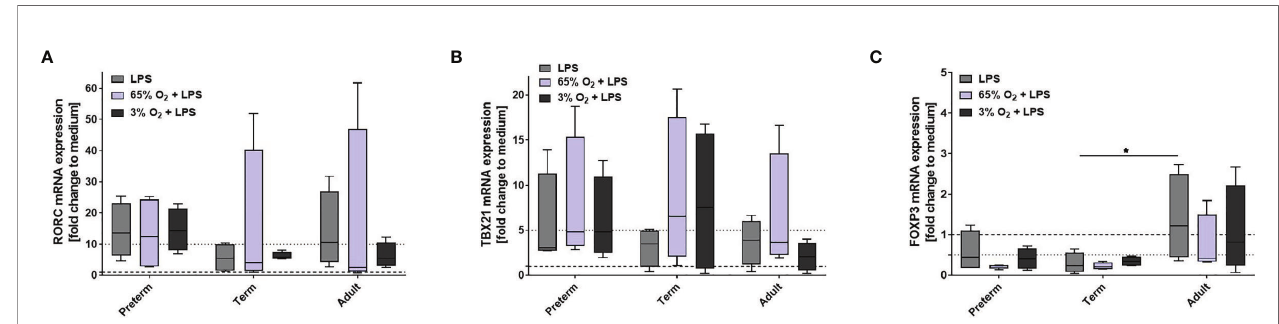
FIGURE 8 | Neonatal CD4+ T cell polarization by supernatants of macrophages (M Ф ) primed with various O 2 concentrations followed by LPS. Neonatal CD4+ T cells were incubated for 6 days with supernatants of preterm, term or adult M Ф after priming M Ф with 65% O 2 or 3% O 2 followed by LPS compared to LPS alone. Supernatants were collected after incubation of M Ф for 72 h (48 h 65% O 2 or 3% O 2 followed by 24 h 21% O 2 with or without LPS). mRNA was assessed using RT qPCR. Box plots of RORC (A) , TBX21 (B) and FOXP3 (C) mRNA expression normalized to b -Actin depicted as a fold change to the medium control. The dotted line at 1 indicates the normalization level and the second dotted line is an auxiliary line for visualization (n=4 independent 72 h supernatants were used (same as Figure 6 ) on neonatal CD4+ cells isolated from one donor, LPS values were re-used from Figure 4 because double-hit conditions were included in those experiments, box plots: median ± 25 th to 75 th percentiles and minimum to maximum, ANOVA followed by Holm-Sidak ’ s test, *p